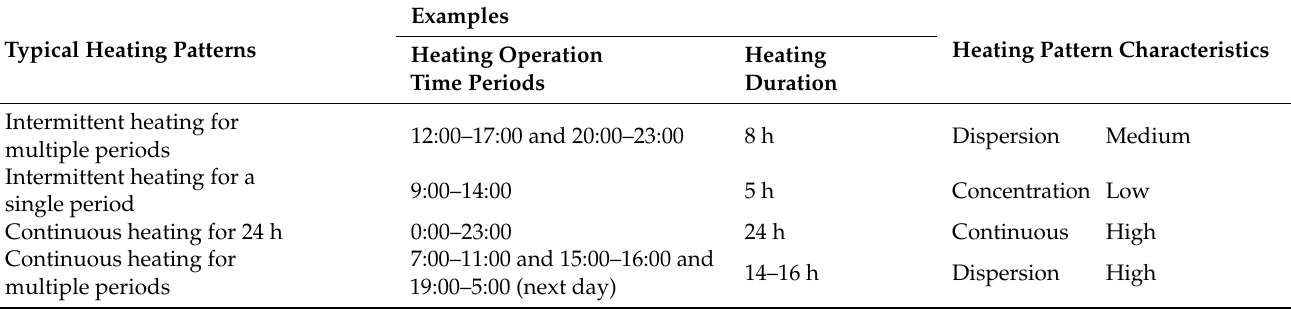
Table 5. Typical heating patterns of the AAHP for heating in rural